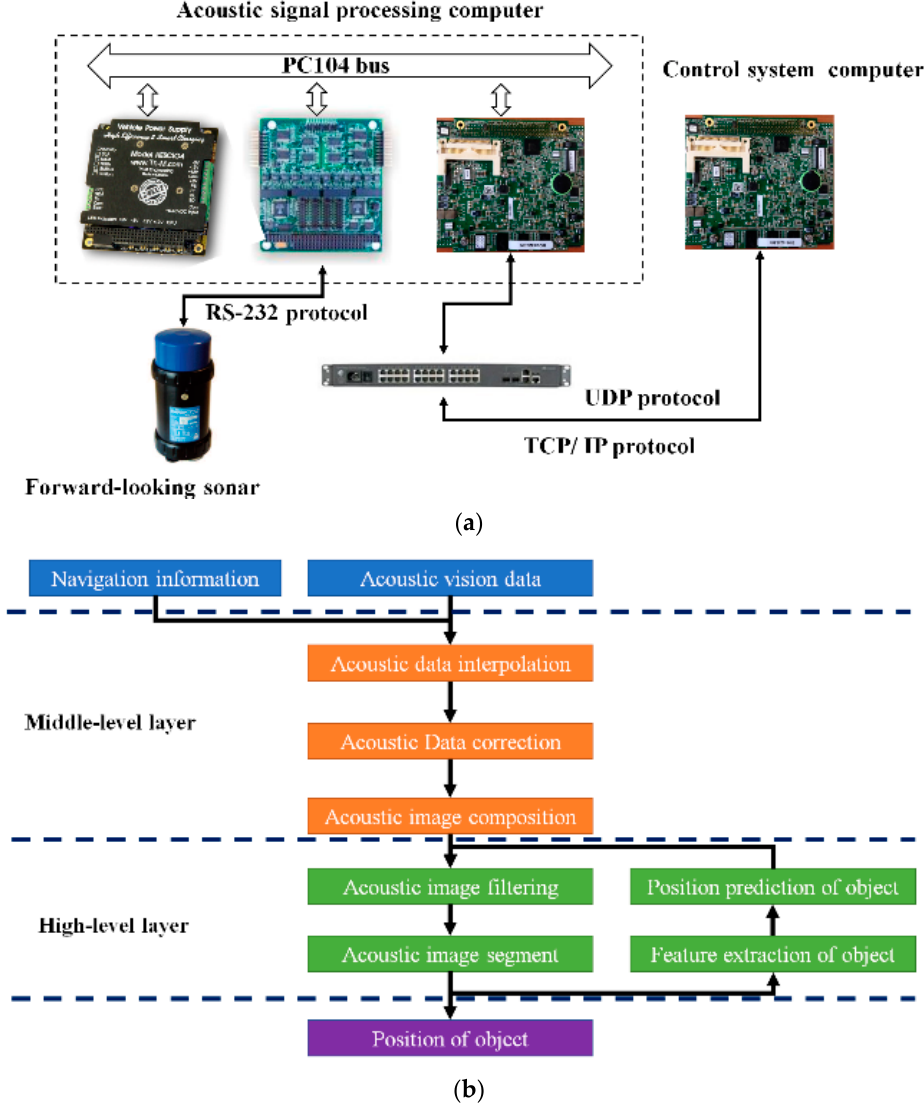
Figure 21. Acoustic-vision-based framework: ( a ) hardware architecture and ( b ) software architecture.